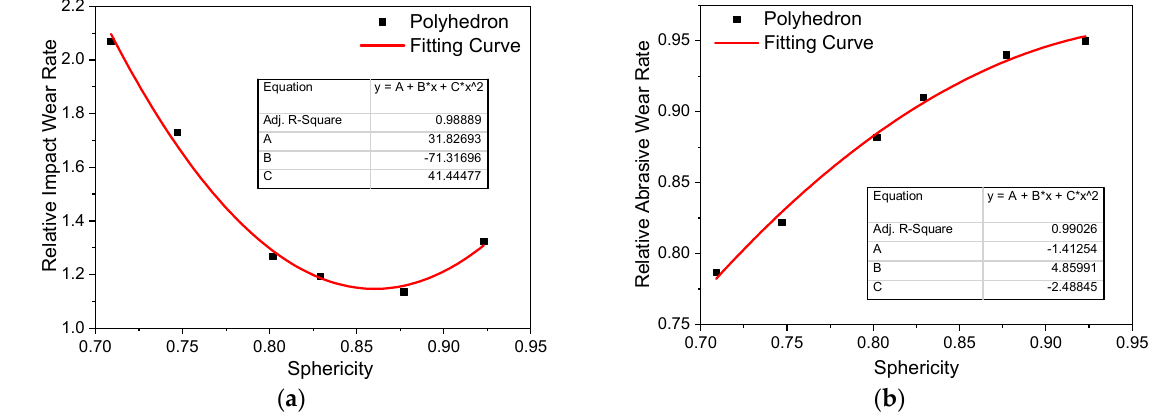
Figure 11. Overall abrasive wear rate of flow parts.